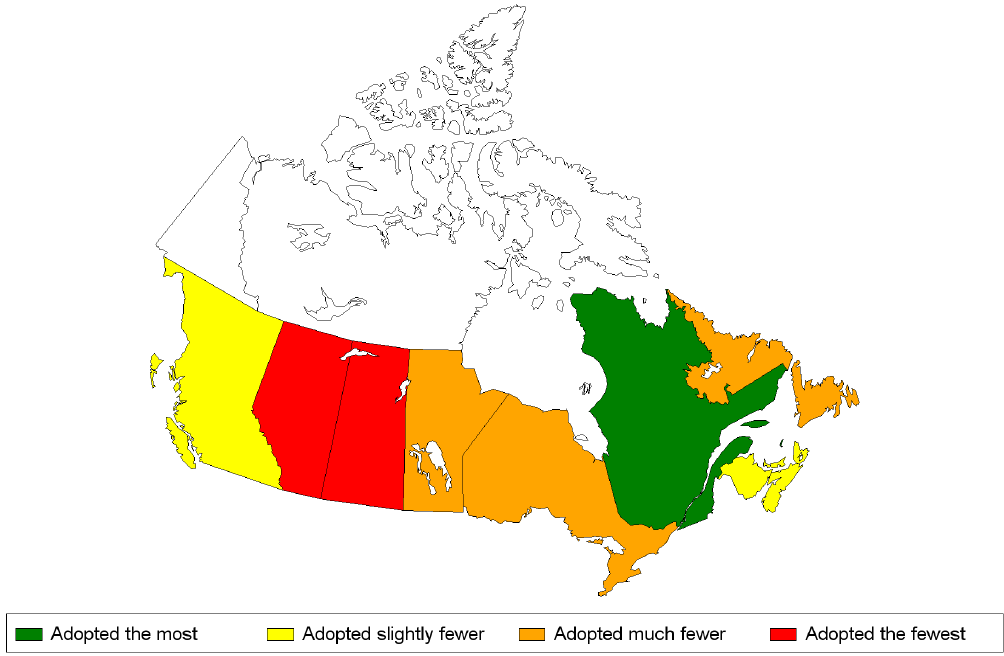
Figure 6. Provinces’ classification according to the four categories of pro-environmental behaviours, Outdoor Index, 2007. Legend : from left to right – British-Columbia, Alberta, Saskatchewan, Manitoba, Ontario, Quebec, New-Brunswick, Nova-Scotia. Prince-Edward-Island is North of the two latter provinces and Newfoundland-and-Labrador is located North-East of Quebec.